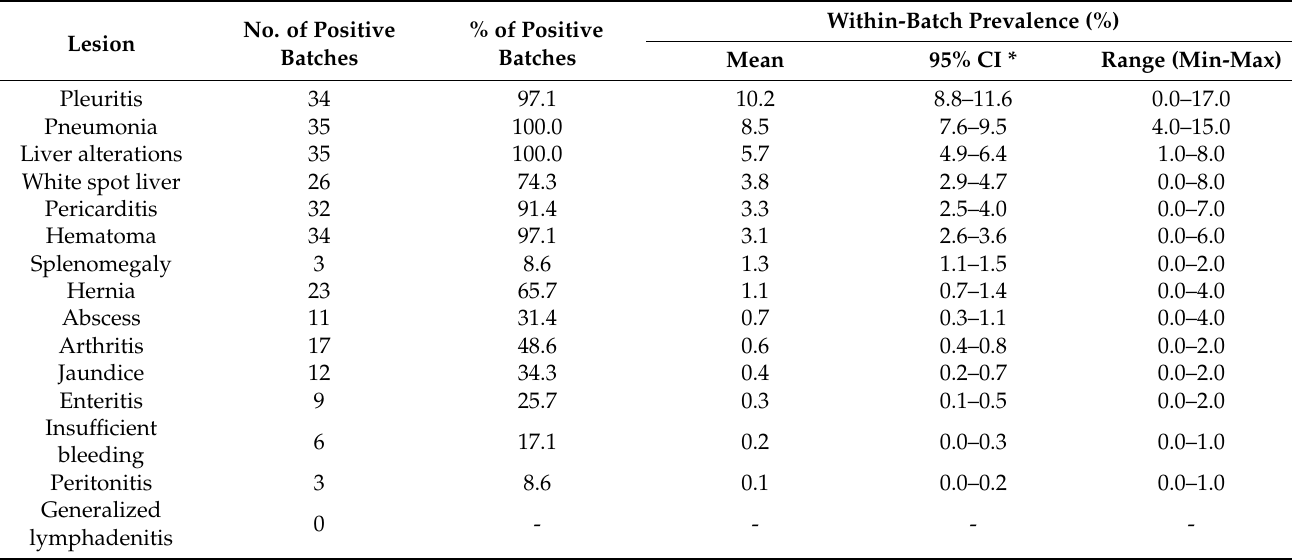
Table 3. Number of positive batches and within-batch prevalence of recorded post-mortem lesions in slaughtered pigs ( N = 35 batches).